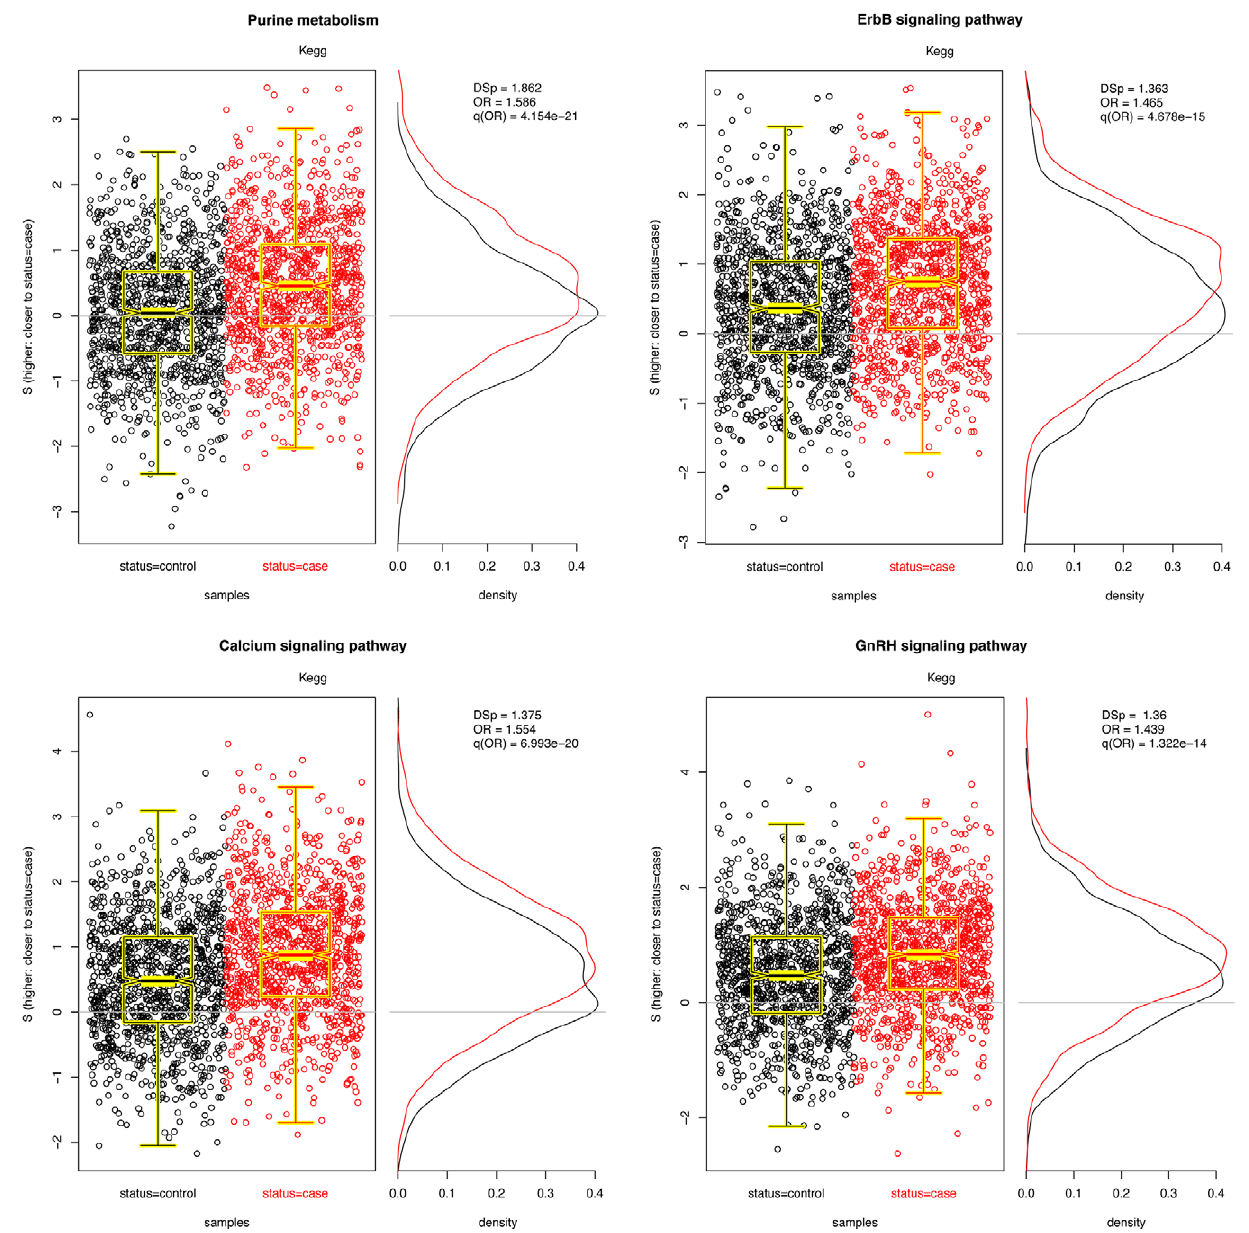
Figure 3. Four significant pathways in breast cancer data. Scatter plots of S Y , P for each pathway are overlayed with boxplots are given in the left panel; higher values of S indicate that the sample is closer to other cases than it is to other controls. Distributions of S for cases (red) and controls (black) are given to the right. A significant shift toward higher S values is seen in the cases. Odds ratios and FDR-adjusted OR p values are given.